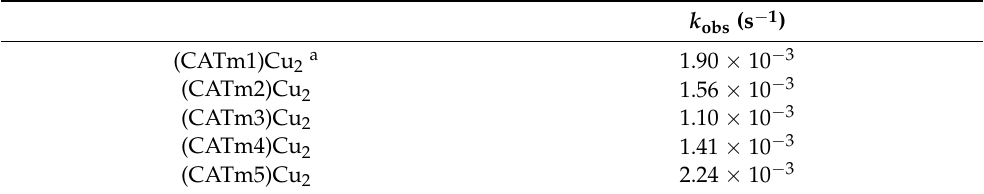
Figure 3. Determination by UV-vis spectrometry at 289 nm of the apparent kinetic constants of degradation product formation for complexes (CATmx)Cu 2 (x = 1 to 5) in MOPS (50 mM, pH 7.5) with an excess of H 2 O 2 (5 mM). Table 2. Rates of catalyst degradation under pseudo-first-order conditions ([H 2 O 2 ] = 5 mM) at 25 °C in MOPS buffer (50 mM, pH 7.5) obtained from the slopes of the lines in Figure 3.